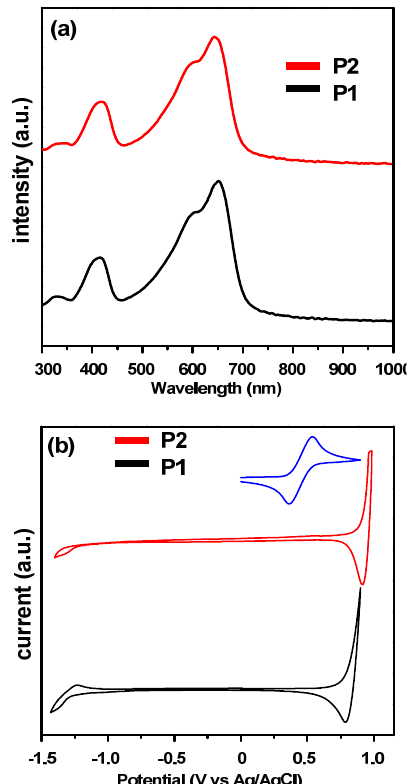
Figure 1. ( a ) Normalized UV-Vis absorption spectra of polymer films and ( b ) cyclic voltammograms (CV) of P1 and P2 .